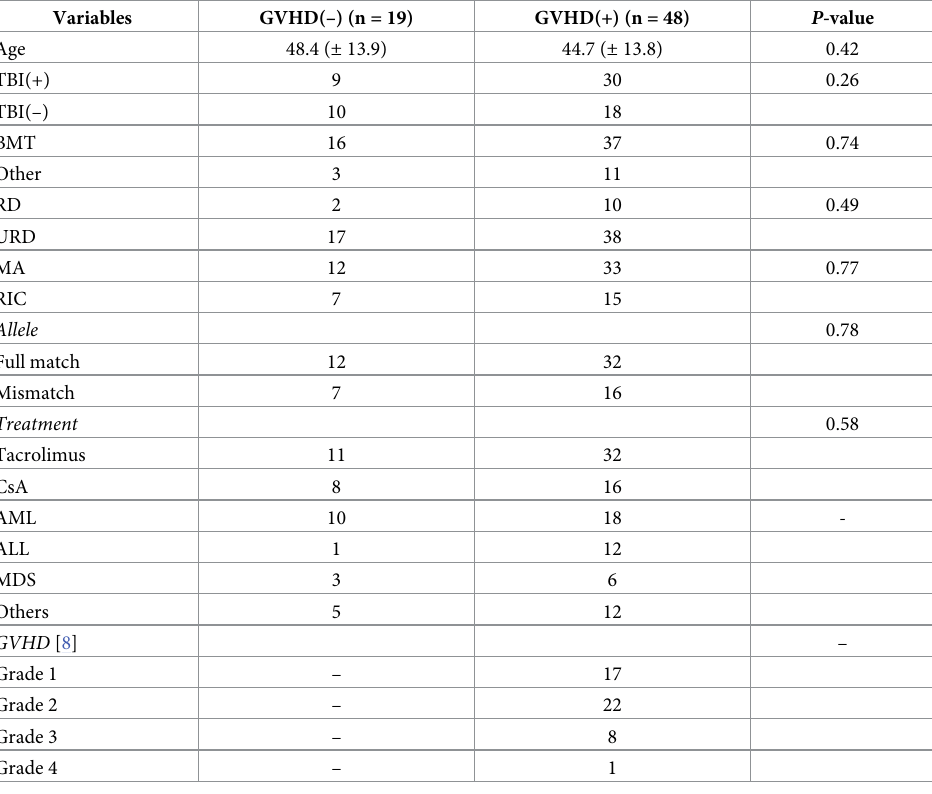
Table 1. Patient characteristics and clinical